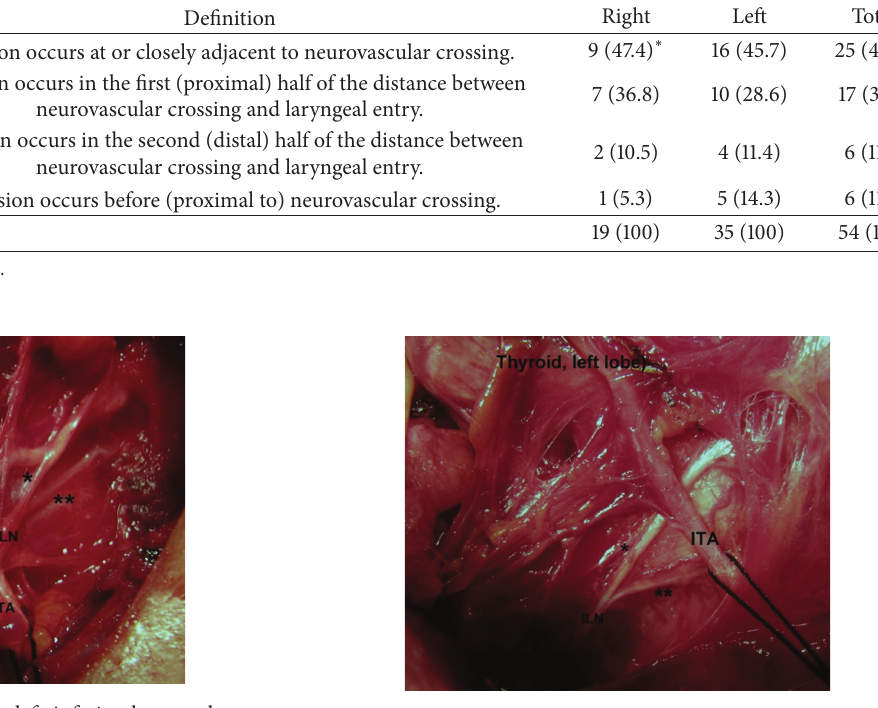
Figure 6: Terminal division of the left inferior laryngeal nerve (ILN) occurs at pre-arterial segment (Type 4). ∗ Anterior branch. ∗∗ Posterior branch. ITA: inferior thyroid